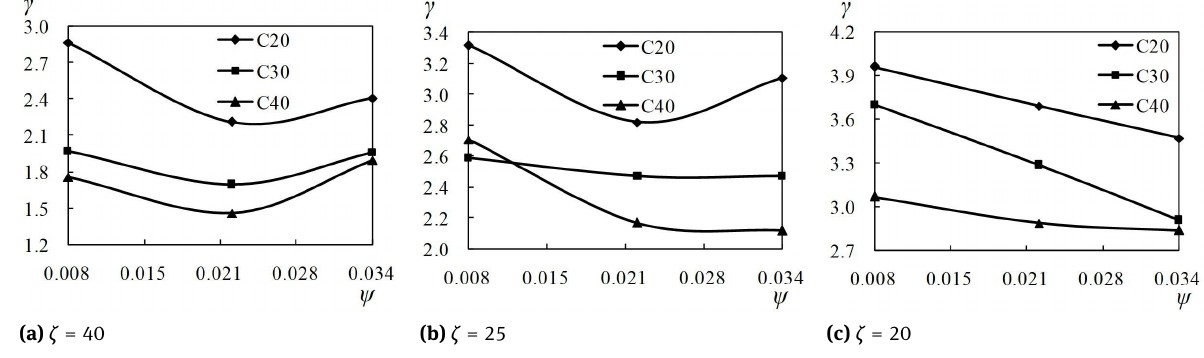
Figure 19: Confinement coeflcient versus steel ratio curves